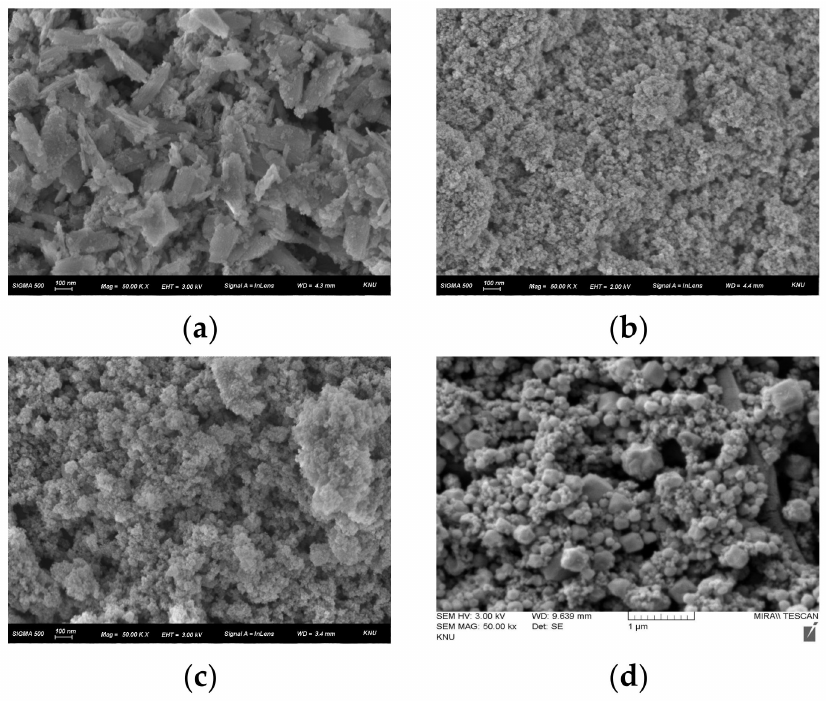
Figure 7. FE-SEM images (50.00k × ) of ( a ) Fe(OH) 3 , ( b ) Fe(OH) 3 @Fe 3 O 4 , ( c ) Fe(OH) 2 EDTA, and ( d ) Fe 3 O 4 @ZIF-8.